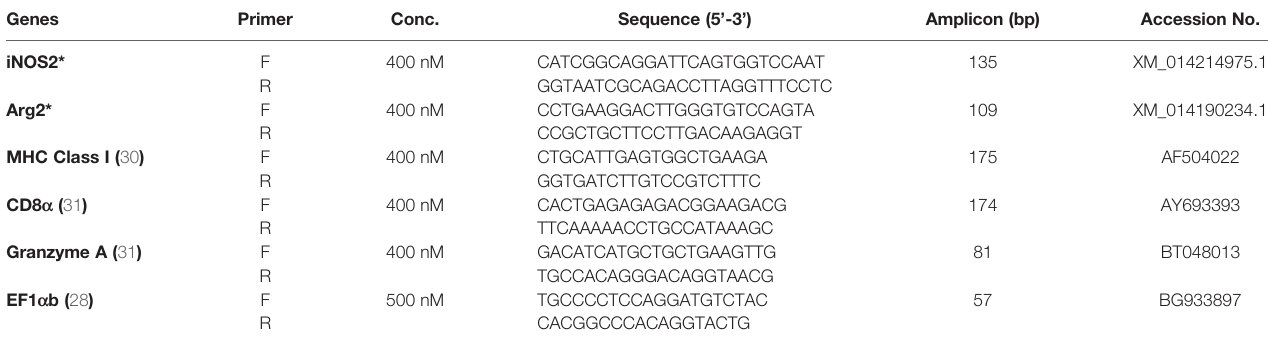
TABLE 2 | List of speci fi c primers for genes of